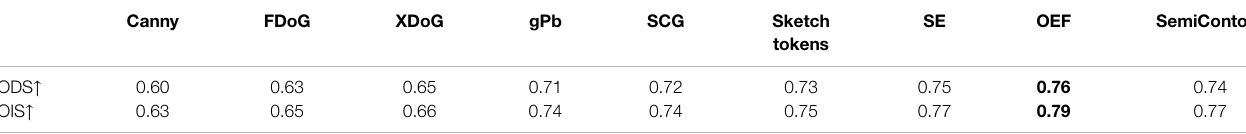
TABLE 1 | Performance comparison of conventional edge detection based algorithms on the BSDS500 dataset. Canny FDoG SemiContour